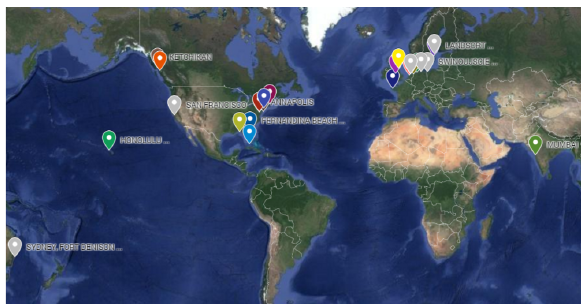
Figure 4: The locations of the tide gauge stations used in this study are indicated with drops (Google map,